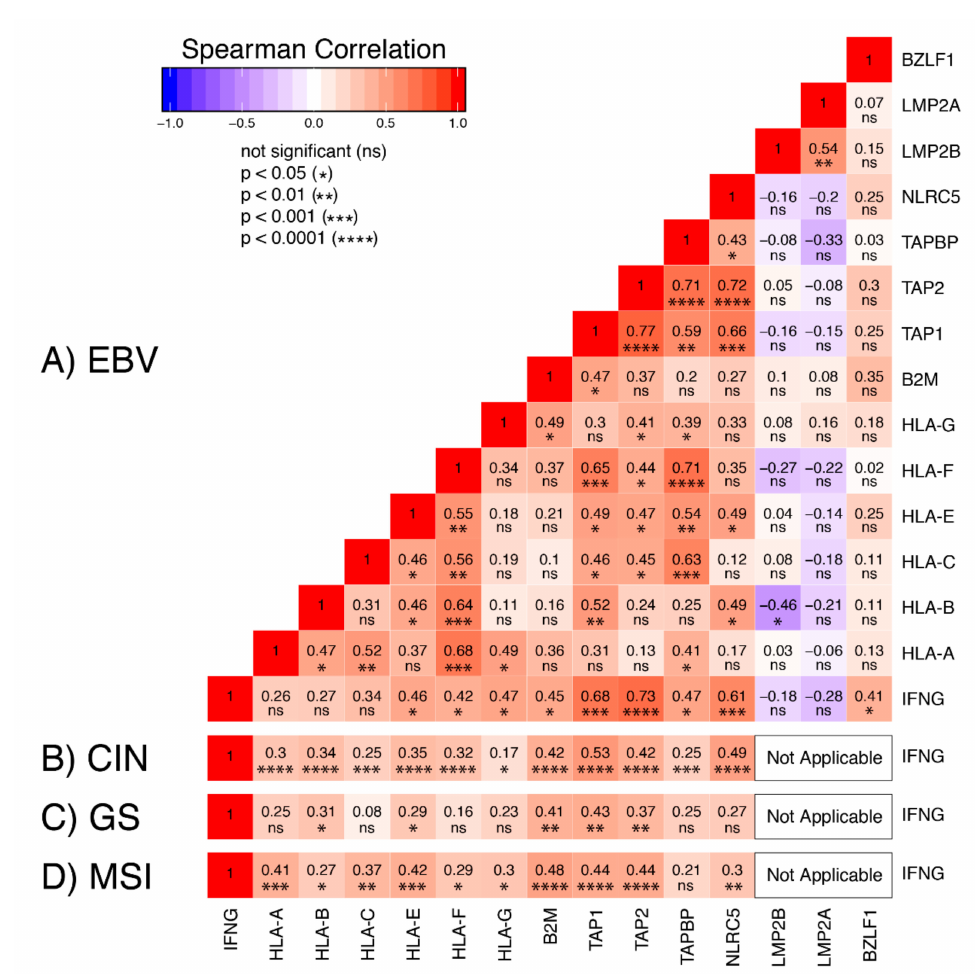
Figure 7. Correlation matrix of selected genes involved in the MHC-I antigen presentation pathway. Heatmap of Spearman correlation analysis of mRNA expression of the indicated MHC-I pathway genes in EBVaGC ( A ). Comparisons with EBV genes reported to antagonize interferon- γ response are also shown. For comparison, Spearman correlations between mRNA levels for interferon- γ (IFNG) and MHC-I pathway genes are also shown for the CIN ( B ), GS ( C ), and MSI ( D ) subtypes. RSEM normalized RNA-seq data for the genes listed above were extracted from the TCGA database for the STAD cohort for EBVaGCs. Pairwise spearman correlations were performed. Numbers in boxes indicate Spearman’s rank correlation coe ffi cient of analyzed gene pairs and p